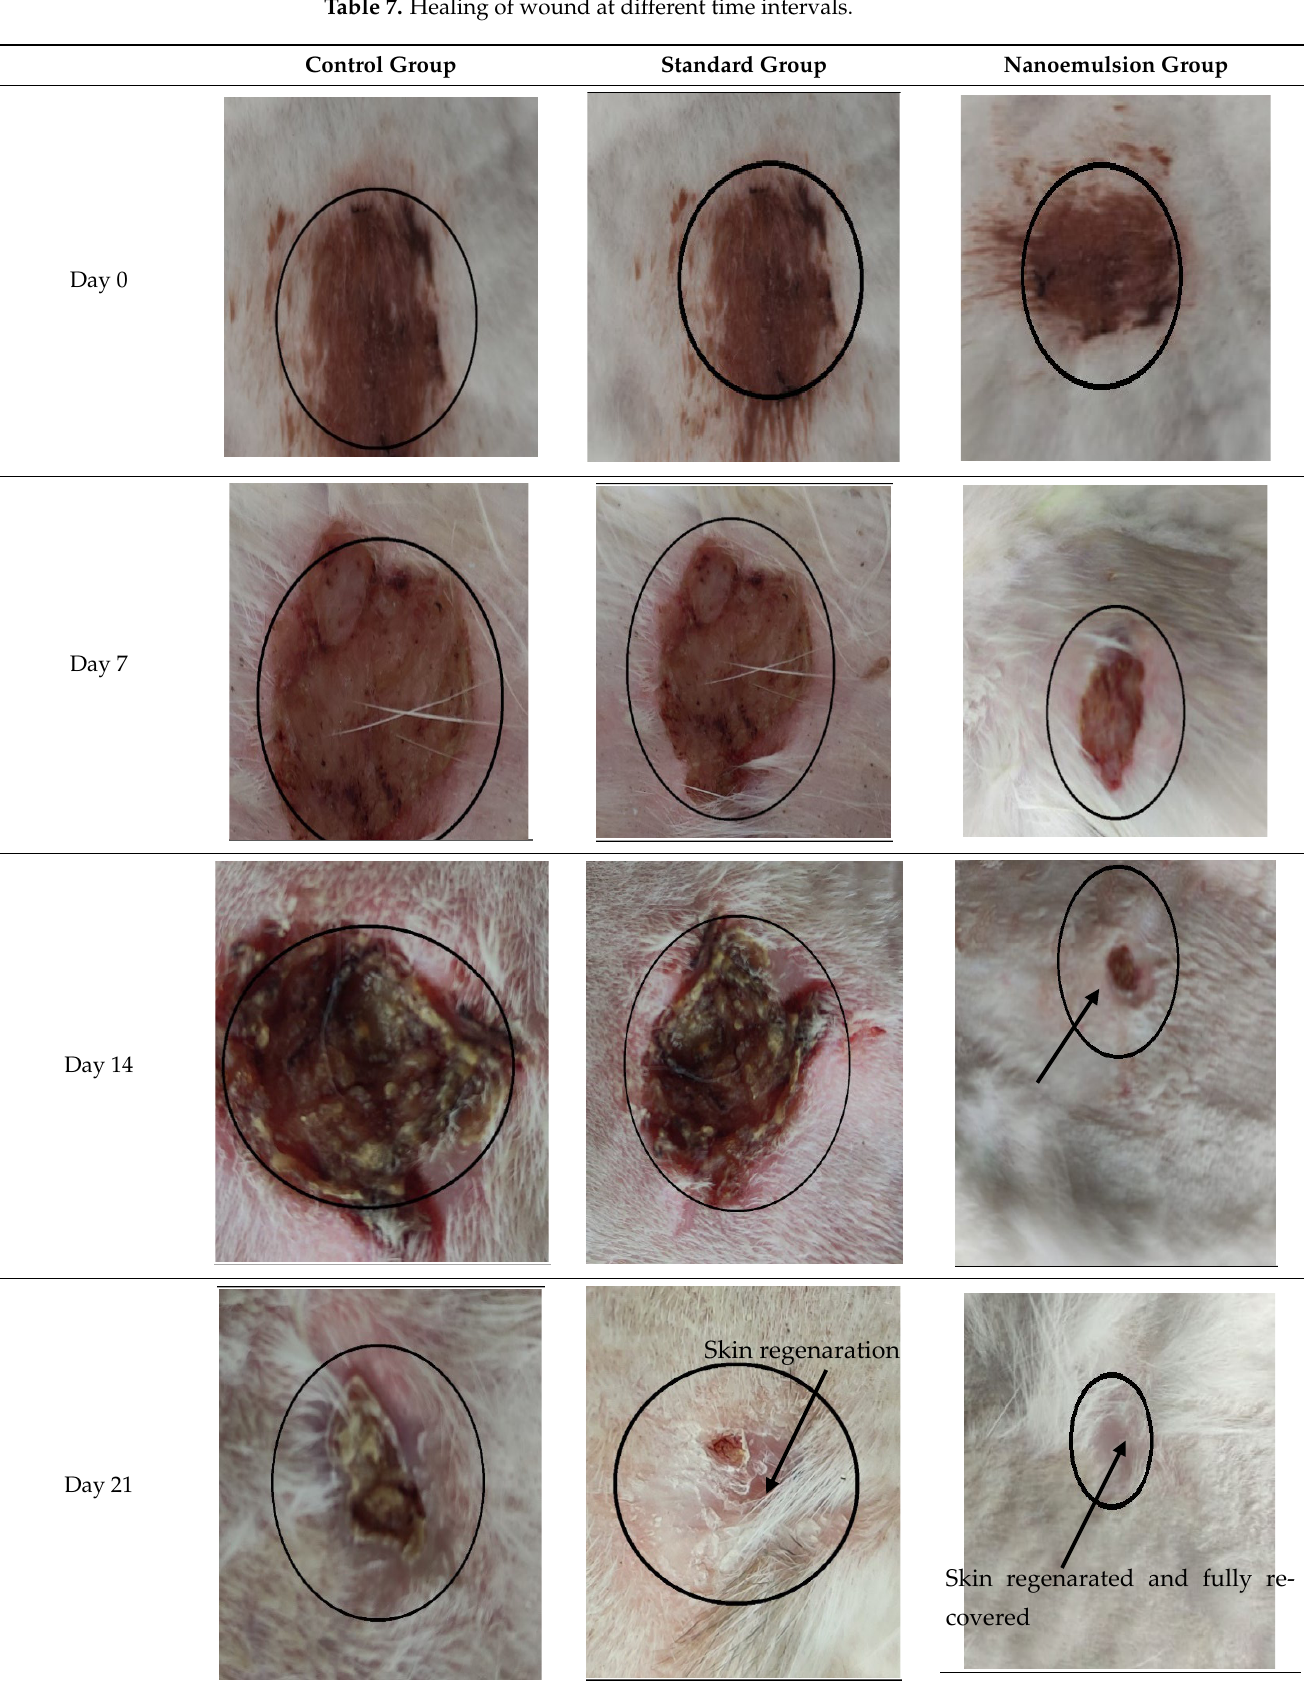
Table 8. Analysis of variance table for healing time (days).